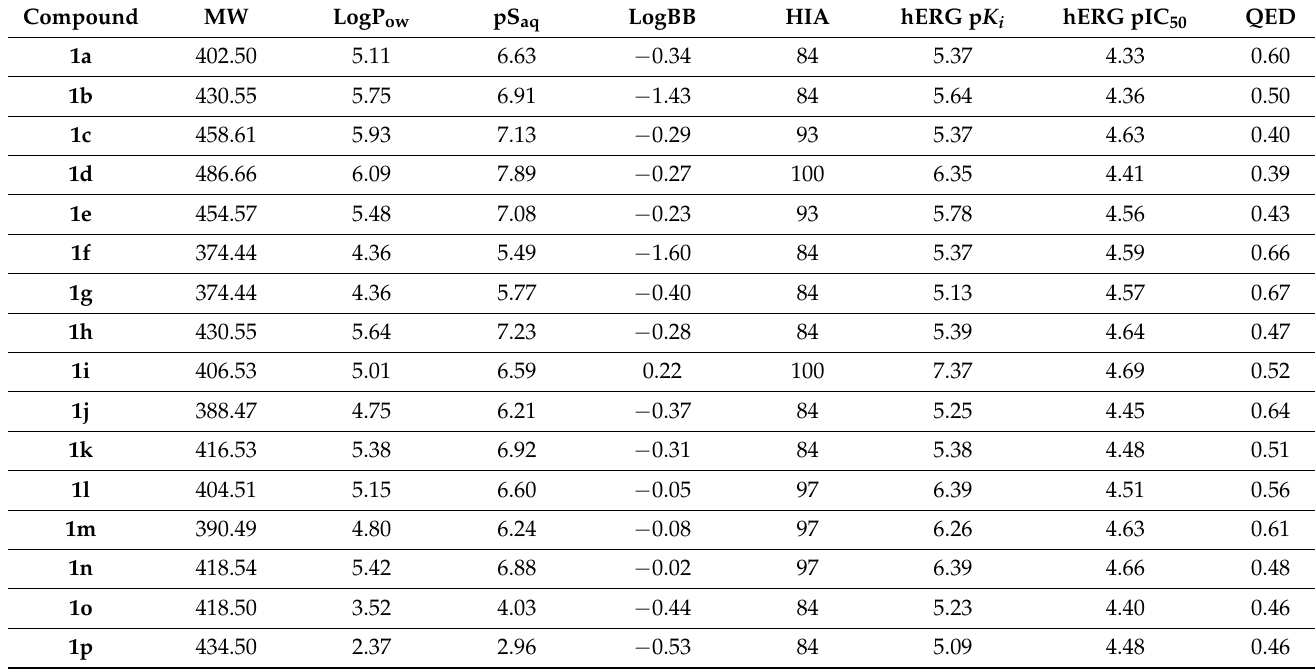
Table 2. Predicted physicochemical and ADMET profiles of compounds 1a – p